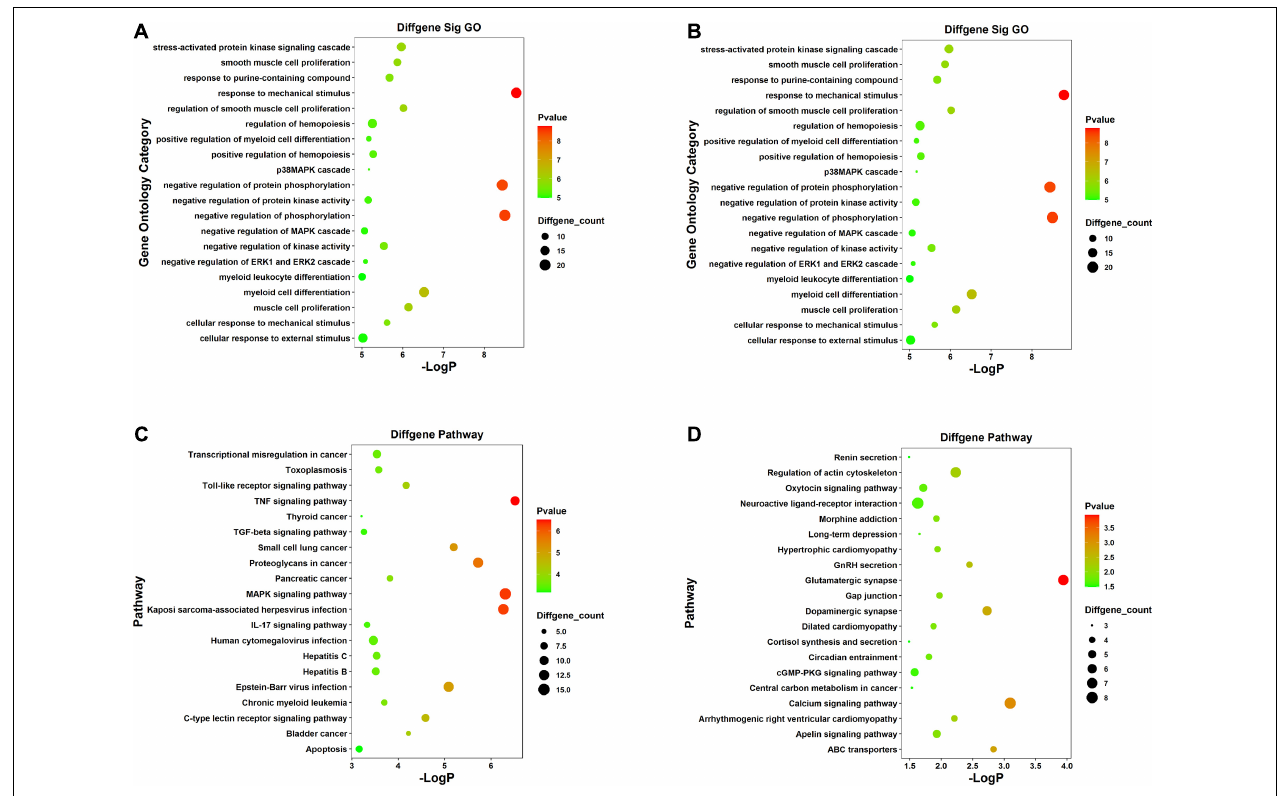
FIGURE 3 | GO and KEGG pathway functional enrichment analysis of the DEmRNAs. (A) The top 20 most significant GO terms of upregulated mRNAs. (B) The top 20 most significant GO terms of downregulated mRNAs. (C) The top 20 most significant KEGG pathway terms of upregulated mRNAs. (D) The top 20 most significant KEGG pathway terms of downregulated mRNAs.